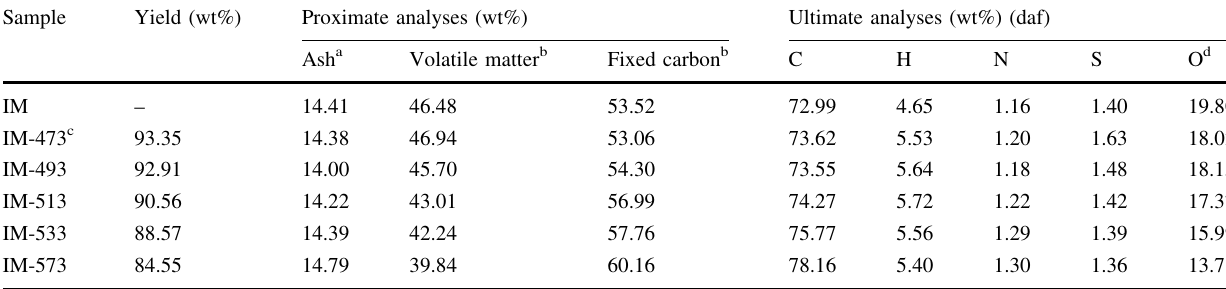
Table 1 Proximate and ultimate analyses of lignites